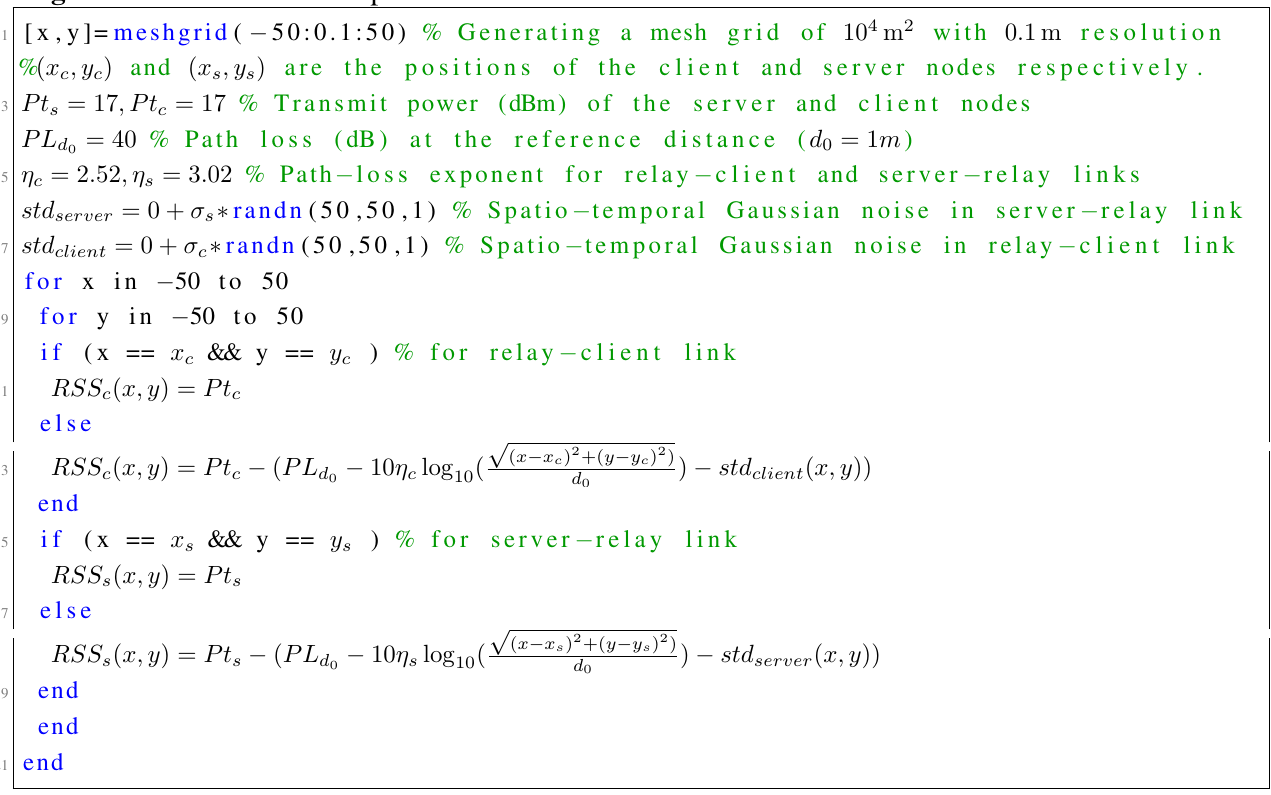
Algorithm 2 Simulation setup for the RSS environment.